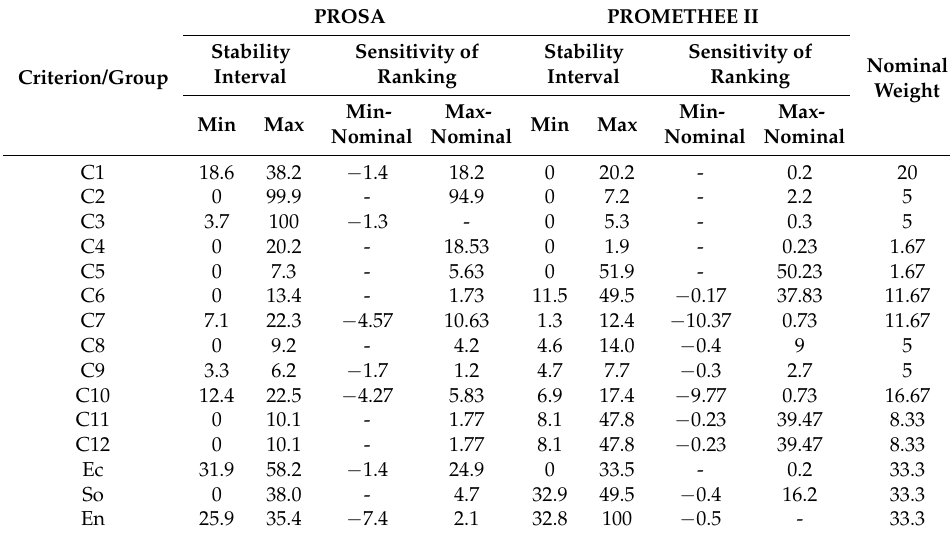
Table 7. Stability intervals of full rankings (all variants) for values of criteria and groups.